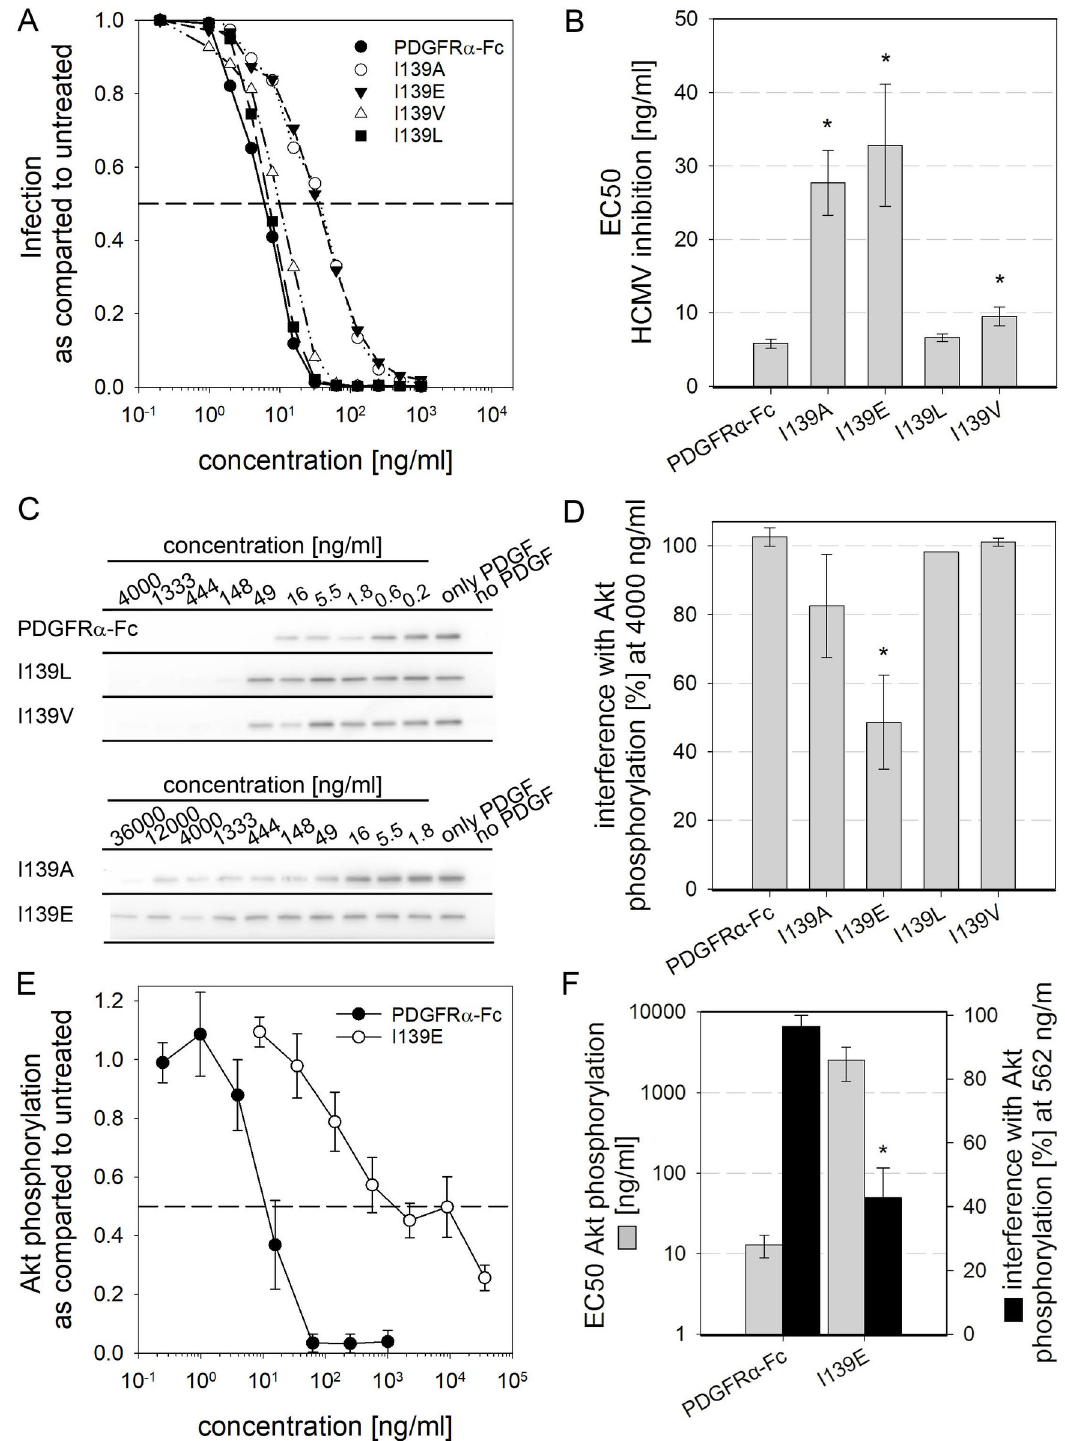
Fig 4. Replacement of isoleucine 139 with glutamic acid improves the inhibition profile of PDGFR α -Fc. A + B: Quantification of HCMV inhibition by the PDGFR α -Fc I139 mutants. TB40-BAC4-IE-GLuc at an MOI � 1 was preincubated with different concentrations of PDGFR α -Fc derivatives before infection of fibroblasts. After 1 day the cells were fixed and stained for the viral immediate early antigens and the percentage of infected cells was determined. Dose-response curves showing the percent of infection relative to a virus only control ( A ) were used as a basis to calculate the half-maximal effective concentrations ( B ). Shown